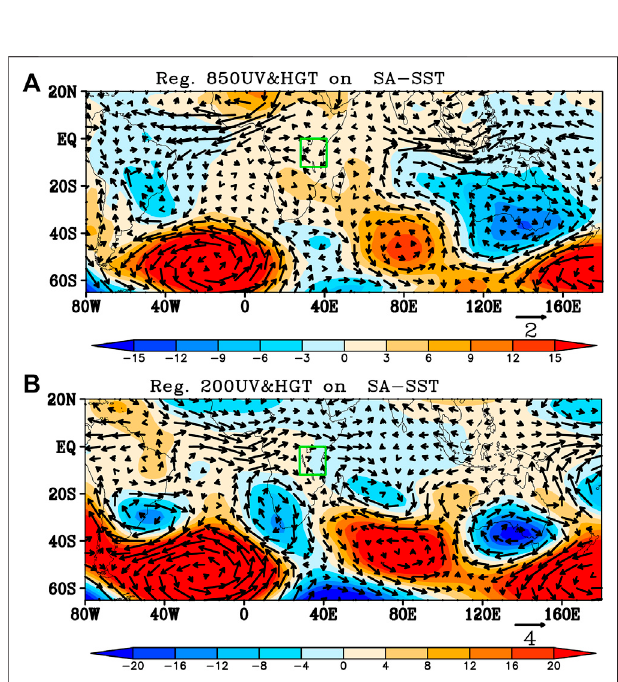
FIGURE 11 | Regressions of (A) 850 hPa horizontal winds (vectors; m s − 1 ) and geopotential height (shading; m), (B) 200 hPa horizontal winds (vectors; m s − 1 ) and geopotential height (shading; m) against the SA-index during OND season for 1950 – 2017.